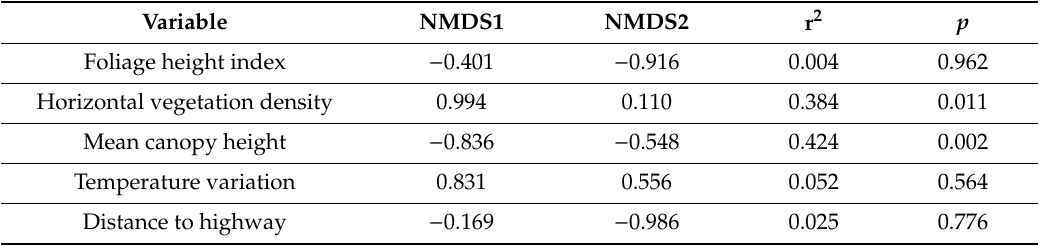
Table A2. Correlation values (r2) between the explanatory variables and the non-metric multidimensional scaling (NMDS) axis that compares forest interiors and forest